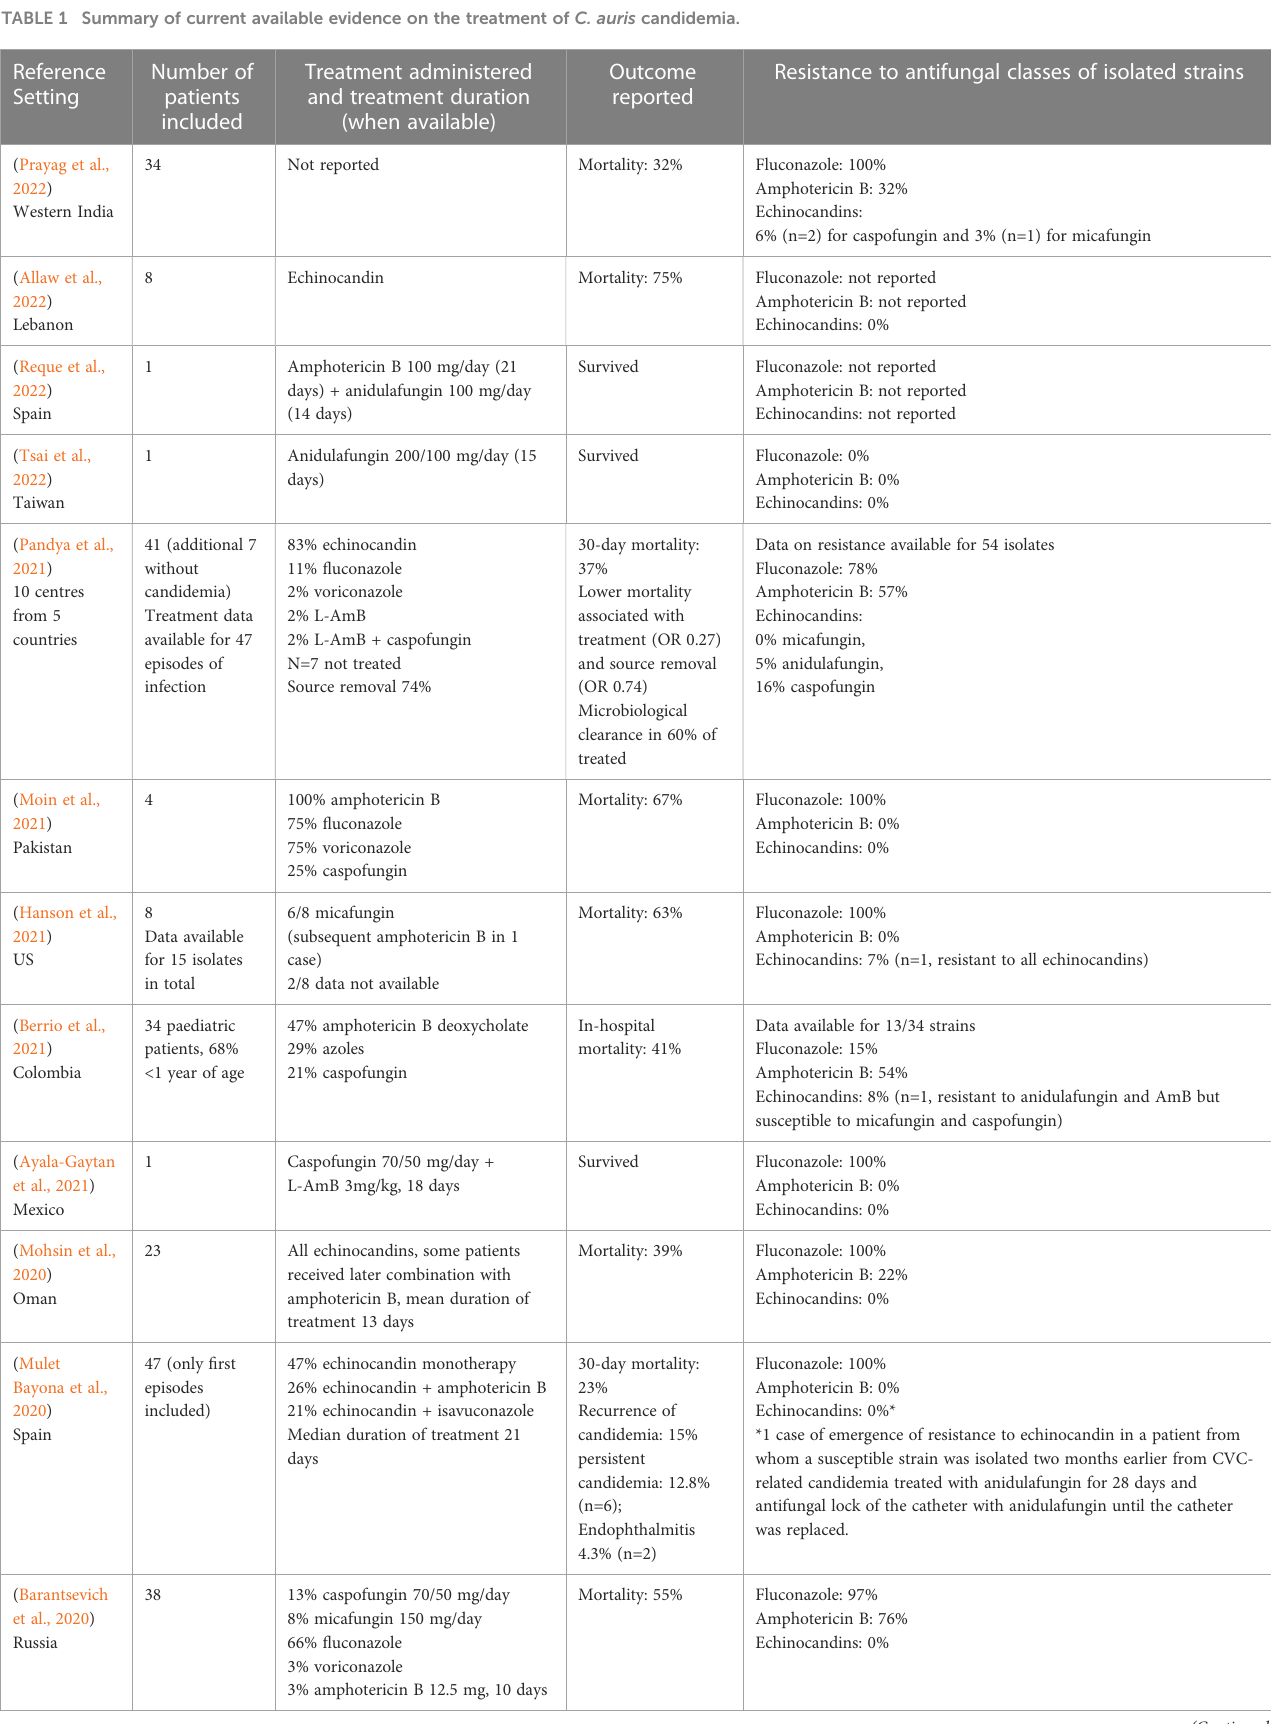
TABLE 1 Summary of current available evidence on the treatment of C. auris candidemia. Reference